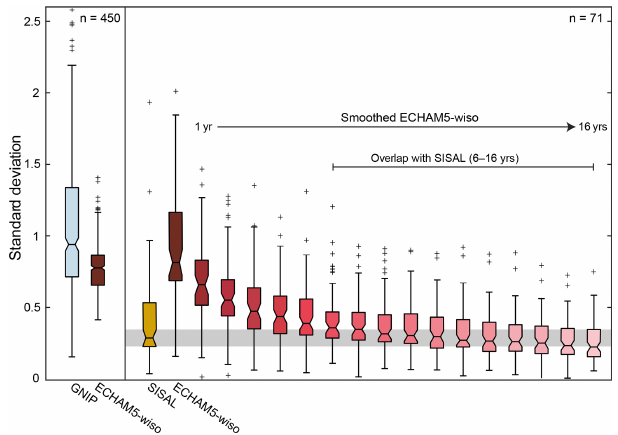
Figure 4. Modern global inter-annual δ 18 O variability. Box plots show the variability of the standard deviation of global annual wδ 18 O using (a) GNIP stations with enough months of data to ac- count for >80% of the annual precipitation and at least 5 years of data ( n = 450) and ECHAM5-wiso data extracted at the location of each GNIP station for the years when these data are available; (b) SISAL records with at least 5 isotope samples for the period 1958–2013 and simulated wδ 18 O p extracted at each cave location for the same years for which speleothem data are available. Box- plots in shades of red are constructed after smoothing the simulated wδ 18 O p data for 1 to 16 years. On each box, the central mark indi- cates the median ( q 2 ; 50th percentile) and the bottom and top edges of the box indicate the 25th ( q 1 ) and 75th ( q 3 ) percentiles, respec- tively. Outliers (black crosses) are locations with standard devia- tions greater than q 3 + 1 . 5 × ( q 3 − q 1 ) or less than q 1 − 1 . 5 × ( q 3 − q 1 ). This corresponds to approximately ± 2 . 7 σ or 99.3% coverage if the data are normally distributed. If the notches in the box plots do not overlap, you can conclude, with 95% confidence, that the true me- dians do differ. The grey horizontal band corresponds to the notch in SISAL for easy comparison. SISAL data were converted to their drip-water δ 18 O equivalent as described in Sect. 2.3.